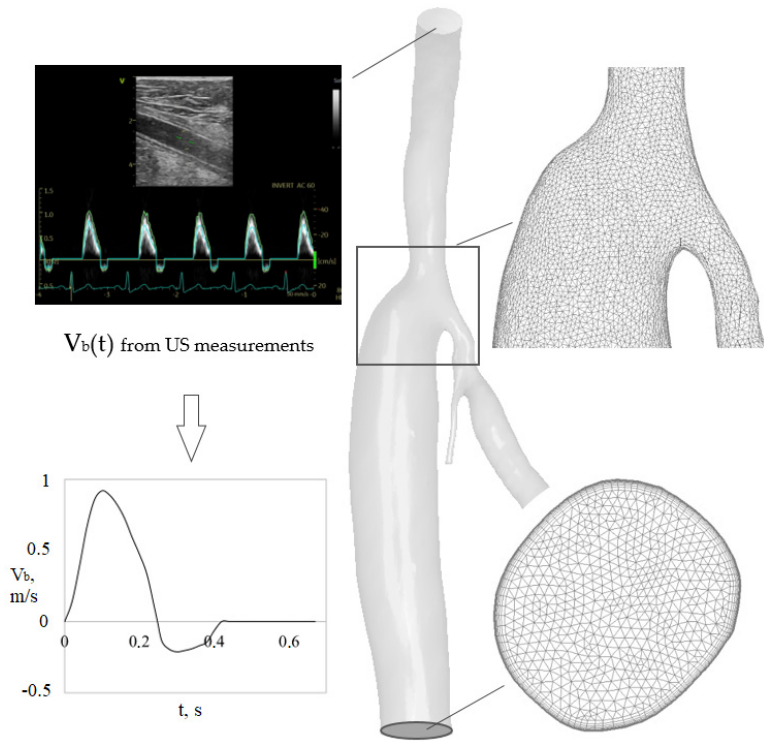
Figure 4. An example of computational grids and inlet boundary conditions used in CFD simula-